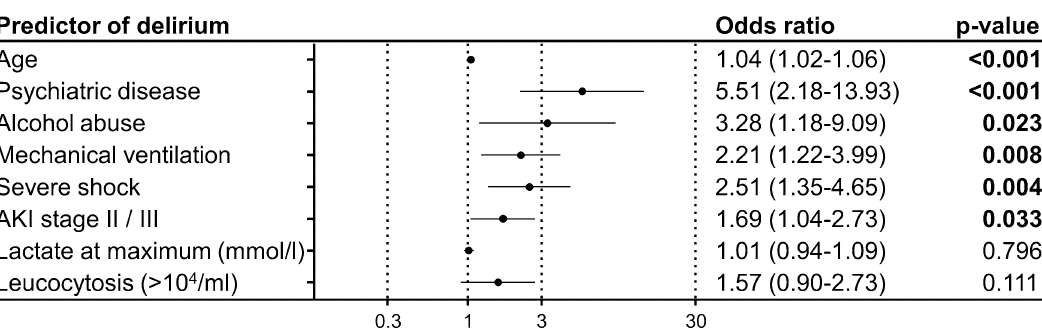
Figure 3. Predictors of delirium on the ICU in patients with acute kidney injury. Graph shows multivariable binary logistic regression analysis with odds ratio (95% confidence interval) of different predictors for delirium in patients with acute kidney injury (AKI) staying for more than 24 h on the ICU.